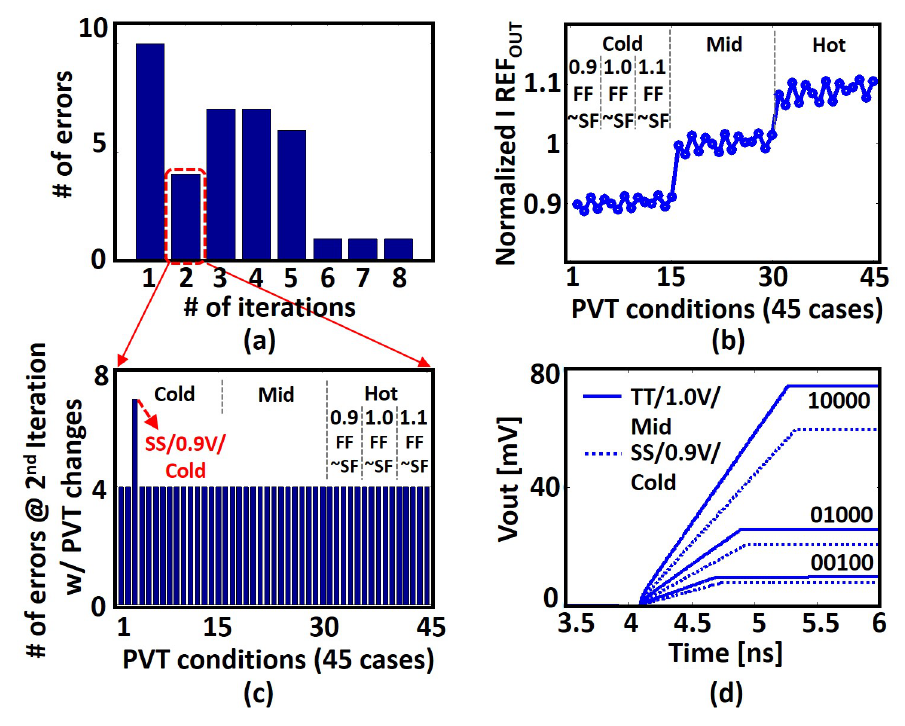
Figure 12. ( a ) Average number of clustering errors during the K-means clustering process; ( b ) normal- ized current reference output with PVT changes; ( c ) the number of clustering errors during second iteration in ( a ) with PVT changes; ( d ) output voltage levels from a distance computing unit with three different inputs under two PVT